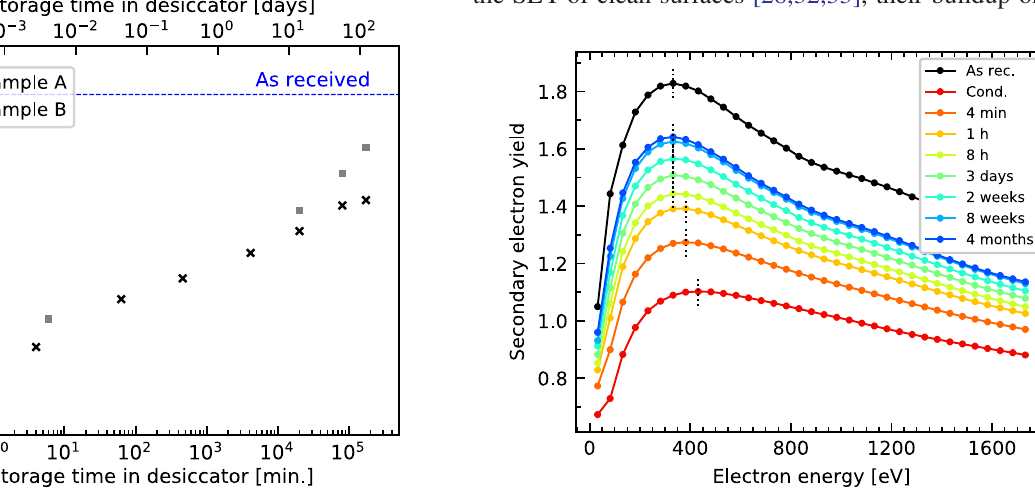
FIG. 1. Evolution of the maximum SEY of two fully condi- tioned OFE copper samples (A and B) during storage in a desiccator. The time t ¼ 0 represents the fully conditioned state.